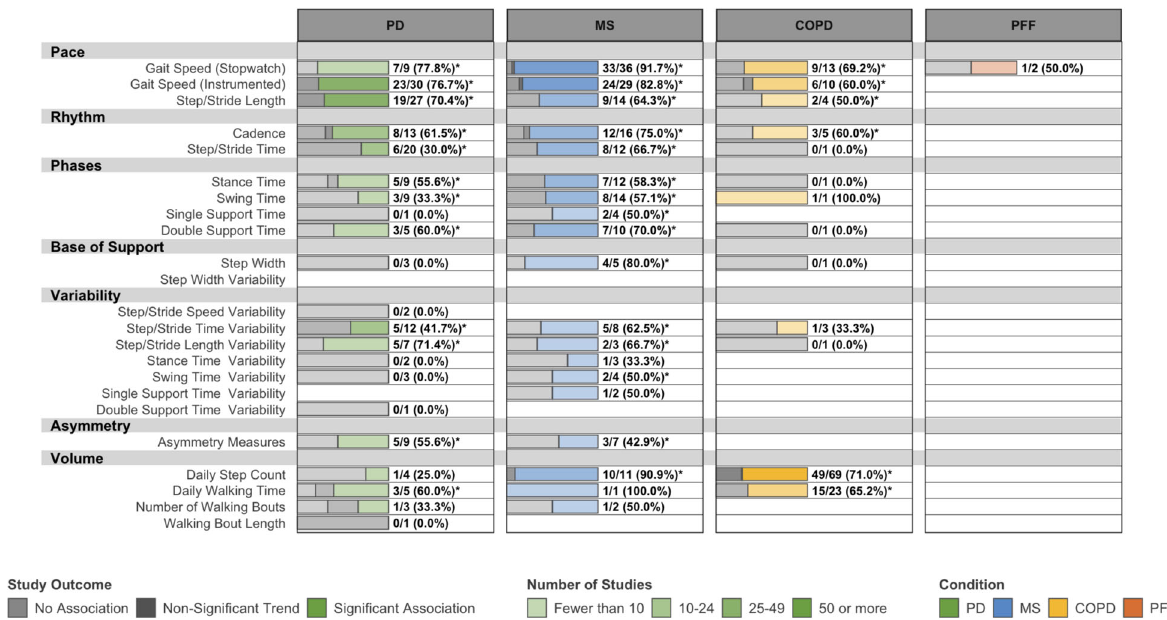
Fig. 4 Convergent validity: associations between DMOs and disease severity measures. PD Parkinson ’ s disease, MS multiple sclerosis, COPD: chronic obstructive pulmonary disease, PFF: proximal femoral fracture. Data are presented as: Number of studies with statistically signi fi cant associations between DMOs and measures of disease severity/Total studies (%). Disease severity measures include the UPDRS, UPDRS-III, and Hoehn & Yahr scale in PD, EDSS, and PDDS in MS, FEV 1 % predicted and GOLD stage in COPD, and patient- or physician-rated global measures of improvement in all four conditions. Most relevant measures in PFF fell under different categories, such as activities of daily living. DMOs known to be highly intercorrelated were grouped (i.e., step length and stride length), and all DMOs were organized according to previously established domains of gait. *Proportion of studies exceeds the expected false-positive rate as determined by Bernoulli hypothesis testing and Benjamini – Hochberg